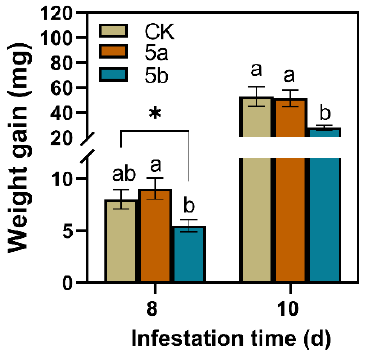
Figure 1. Mean larvae weight gain of tea geometrid (TG) (±SE, n = 22-28) fed on JA-Ile-macrolactones - treated tea leaves. Different letters indicate significant differences among treatments ( p < 0.05, Turkey’s test ). The asterisk indicates significant difference between treatment and control ( p < 0.05, Student’s t -test).